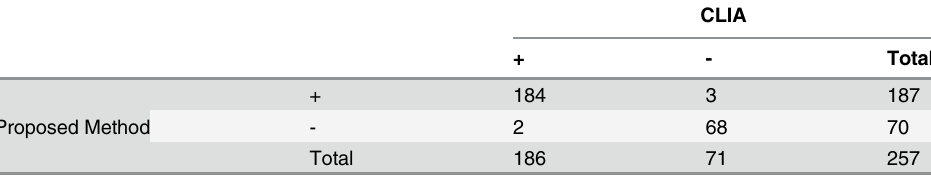
Table 5. McNemar ’ s test between the proposed method and CLIA for the test of 257 HBeAg samples.